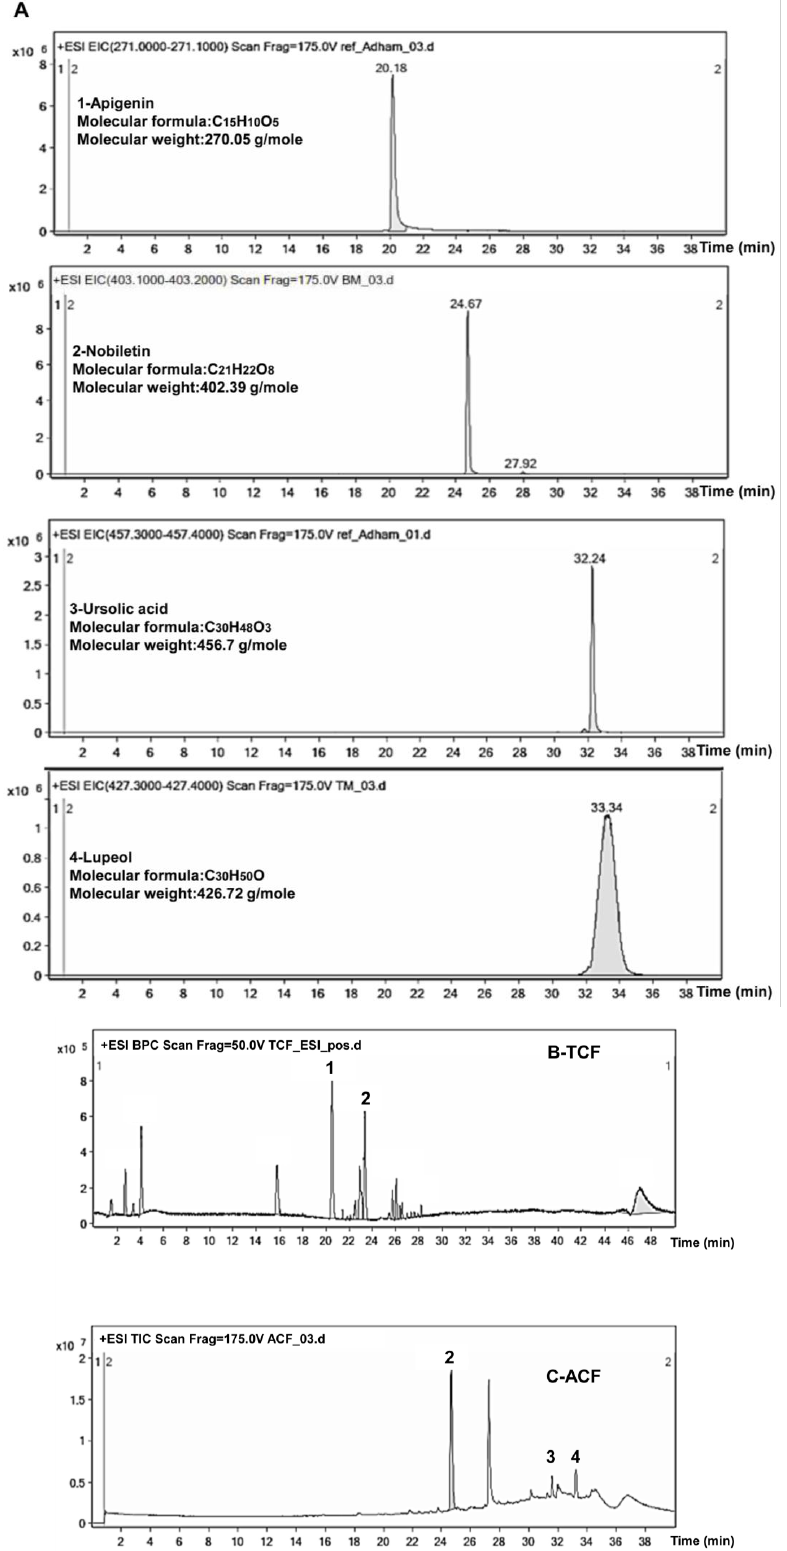
Figure 7. LC-ESI/MS chromatograms T. vulgaris and A. lappa extracts. ( A )-Standard compounds. (1) Apigenin, (2) Nobiletin, (3) Ursolic acid, and (4) Lupeol. ( B )- T. vulgaris chloroform fraction (TCF) and ( C )- A. lappa chloroform fraction (ACF).